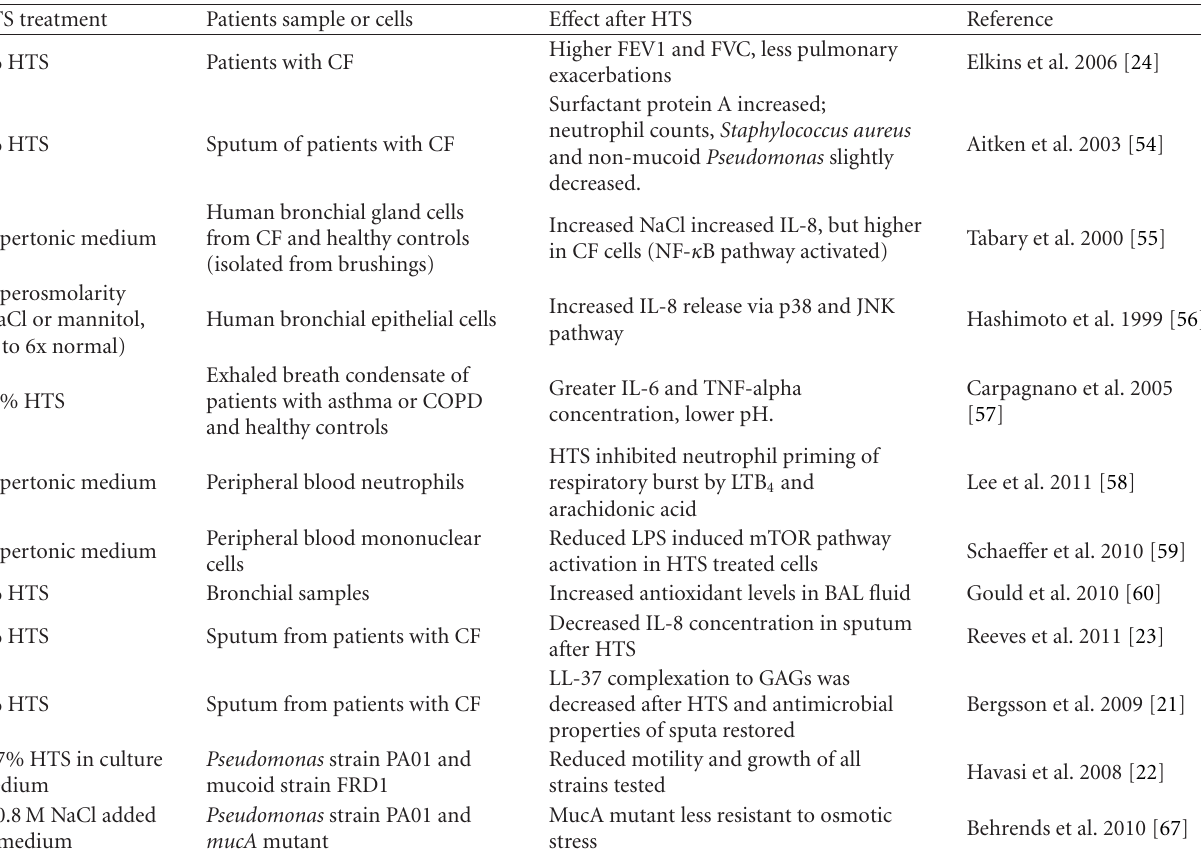
Table 1: The reported e ff ects of hypertonic saline on infection and